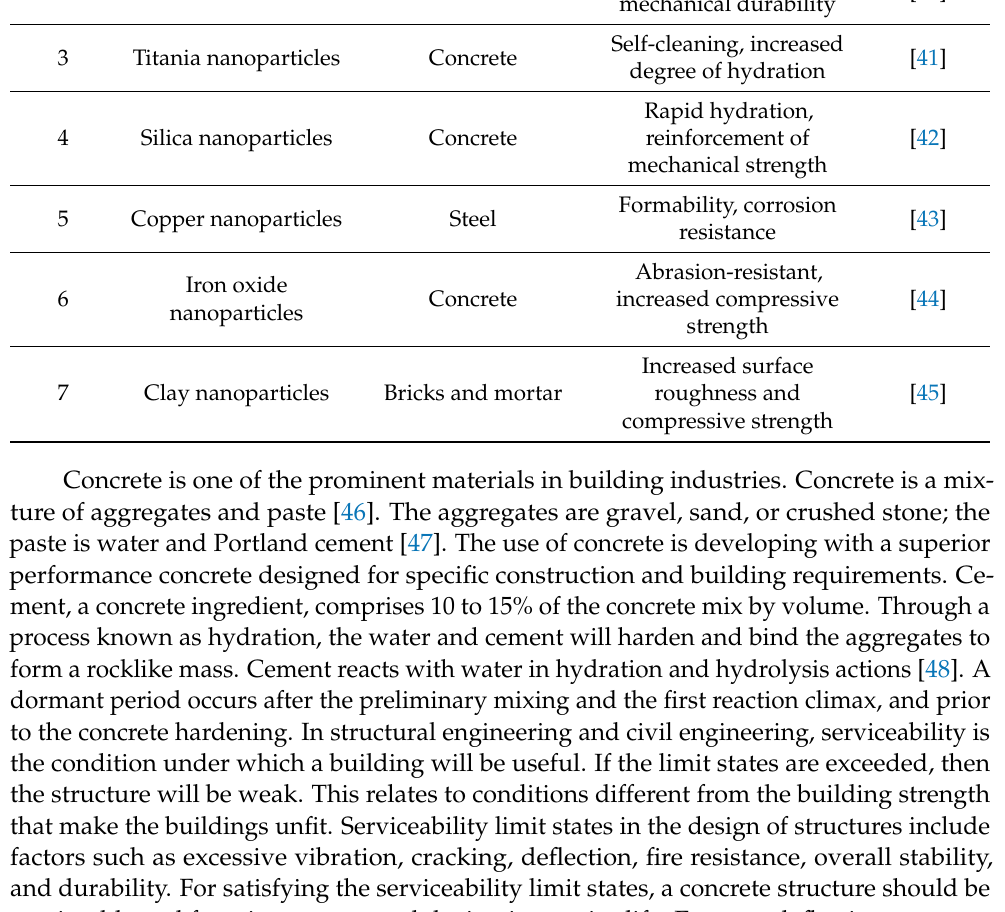
Table 1. Some of the utilizations of nanomaterials in the construction industry. Application Area Properties Reference Sl. No. Nanomaterial Used in Construction Aluminium oxide Asphalt concrete, Increased serviceability [39] 1 nanoparticles timber Crack prevention, 2 Carbon nanotubes Concrete mechanical durability Self-cleaning, increased 3 Titania nanoparticles Concrete degree of hydration Rapid hydration, 4 Silica nanoparticles Concrete reinforcement of mechanical strength Formability, corrosion 5 Copper nanoparticles Steel resistance Abrasion-resistant, Iron oxide 6 Concrete increased compressive nanoparticles strength Increased surface 7 Clay nanoparticles Bricks and mortar roughness and compressive strength